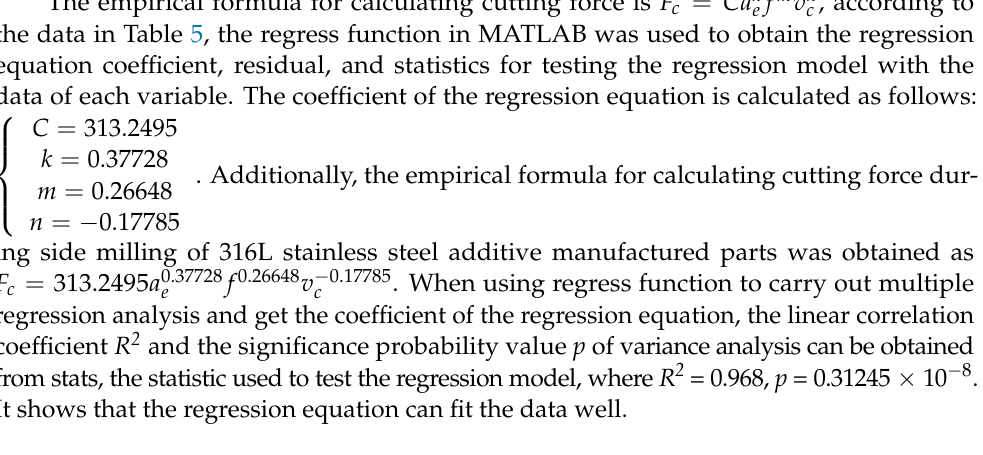
Figure 19. ( a ) Side milling for the AM block specimen; and ( b ) block specimen after orthogonal side milling test.